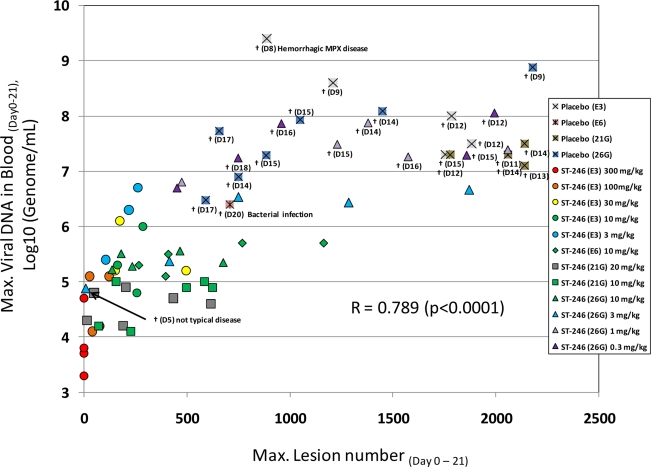
Correlation between maximum monkeypox viral DNA levels in the blood versus maximum lesion number in non-human primates infected with monkeypox virus. Viral DNA levels were determined by quantitative PCR assay. Maximum viral DNA levels and lesion number were determined over a period of 21 days starting at the time of infection (Day 0). All doses were administered by oral gavage. Dose levels ranged from 0.3 mg/kg/day to 300 mg/kg/day for 14 days. Treatment was initiated on Day 1 (E3), Day 5 (E6), Days 3 or 4 (21G) or lesion onset on Day 3 or 4 (26G). Studies 21G and 26G were randomized, double blind, placebo-controlled studies conducted in compliance with GLP guidelines. Pearson’s correlation coefficient was calculated to show the degree of correlation.